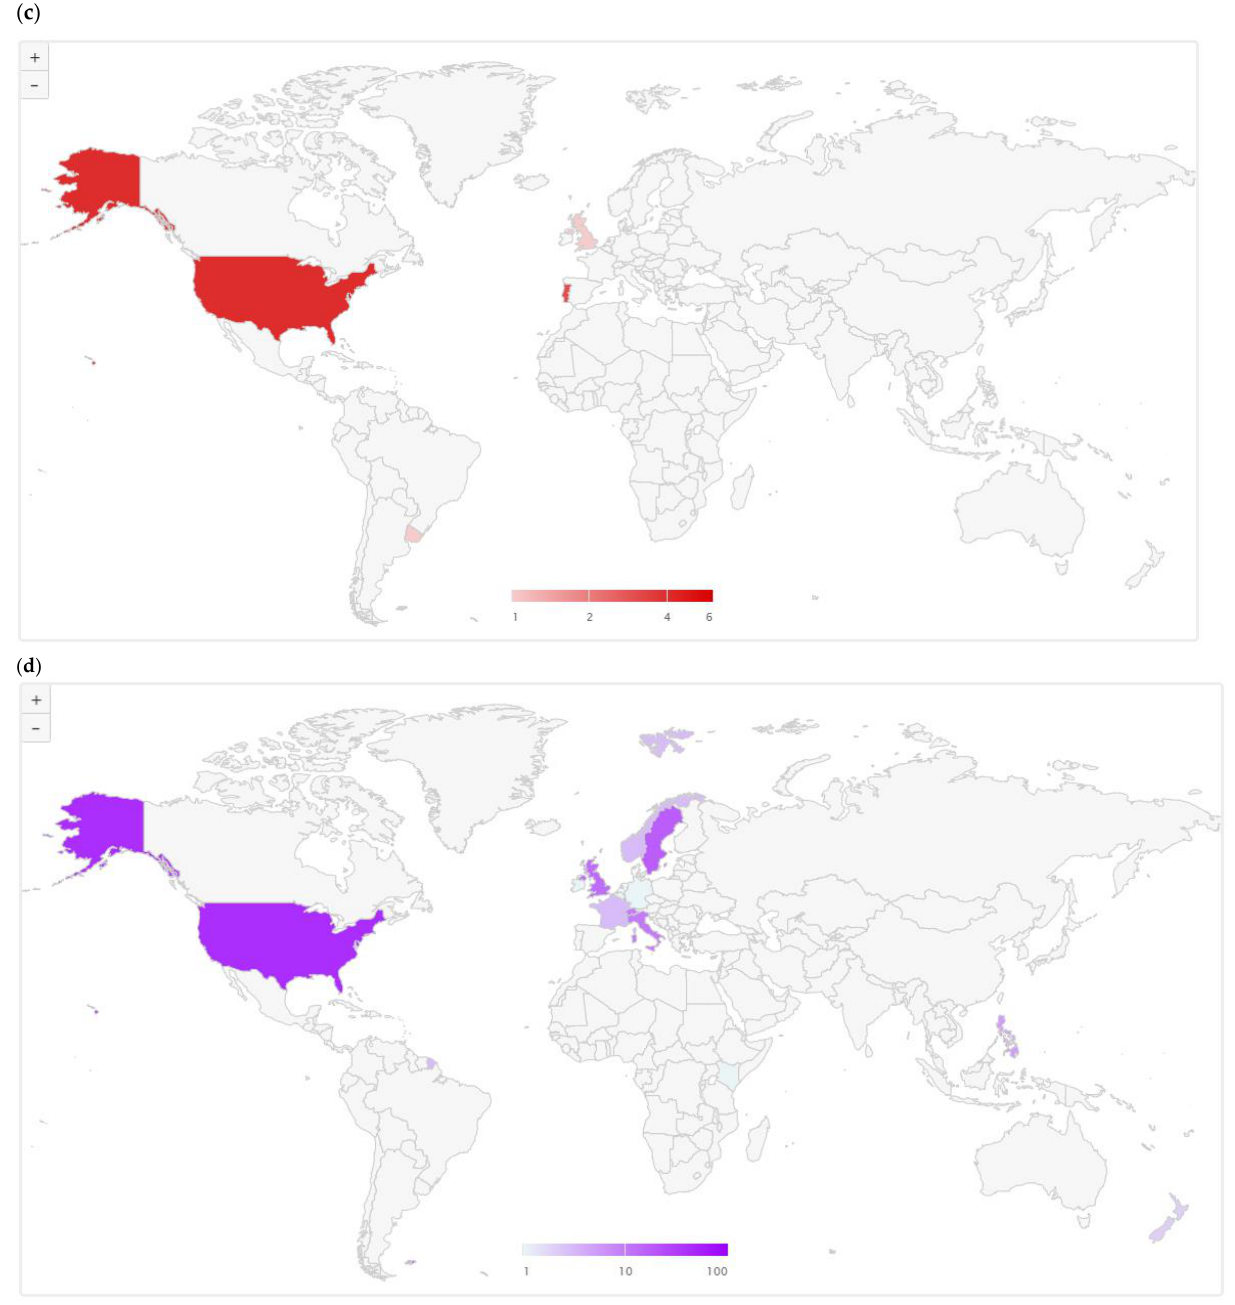
Figure 6. Demographics of environmental valuation research from the Altmetric Explorer: ( a ) Twitter, ( b ) Facebook, ( c ) news stories, ( d ) policy.